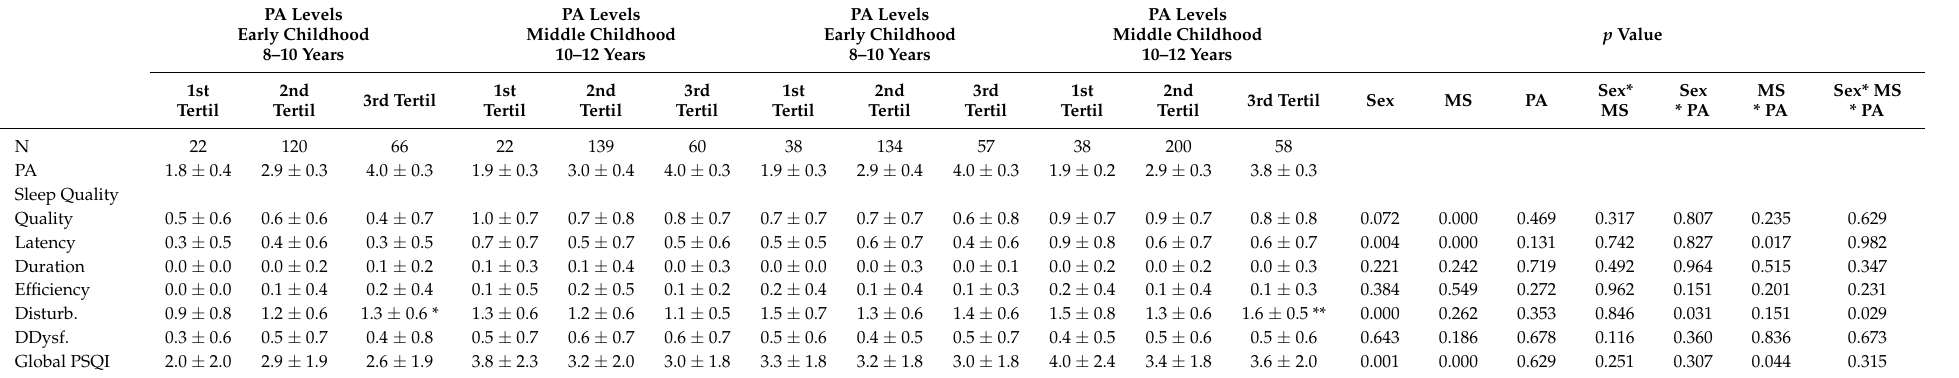
Table 2. Interaction between physical activity, sex, and maturational stage and their mediation on sleep